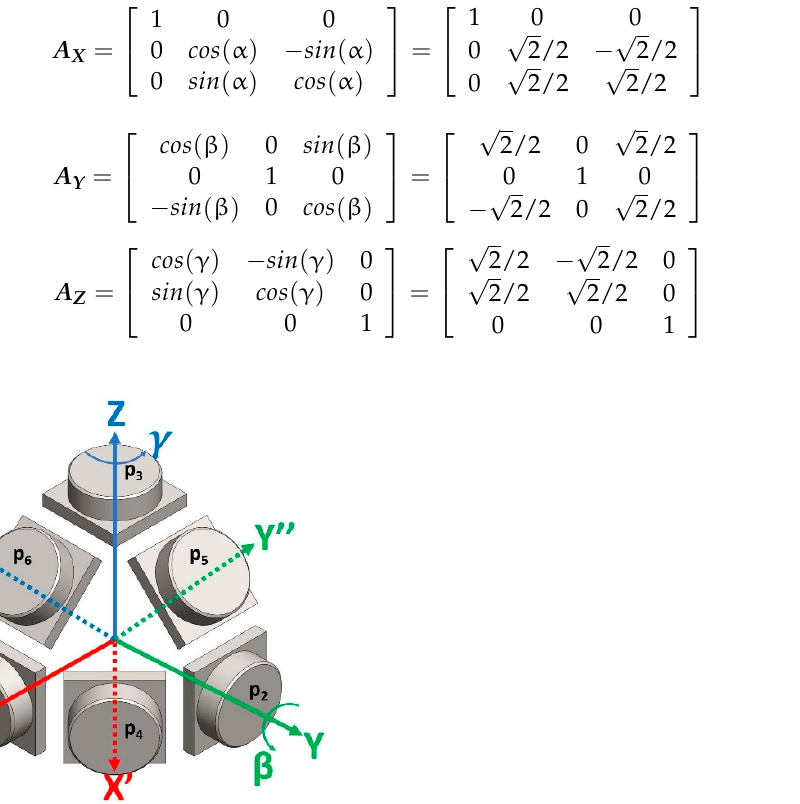
Figure 1. MAPS probe hexad pressure sensor disposition: the six sensors are disposed in a cartesian triad XYZ plus the bisectors of the first triad axes X (cid:48) , Y (cid:48)(cid:48) , and Z (cid:48)(cid:48)(cid:48)